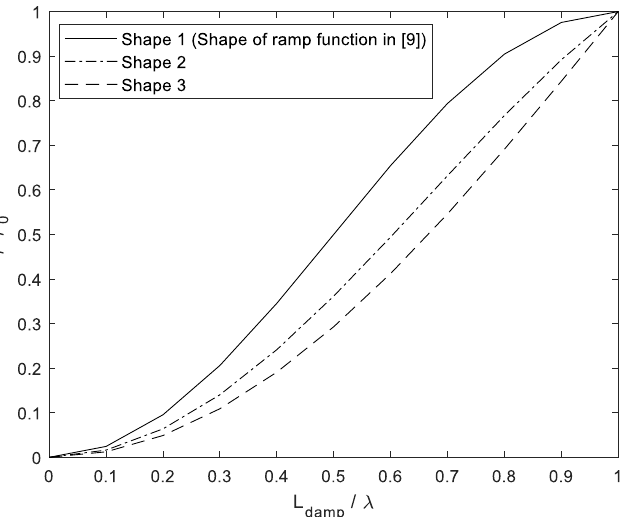
Figure 7. Various shapes of the ramp function for the damping coefficients: shape 1 ( 𝜃 = 𝜋 ), shape 2 ( 𝜃 = 3𝜋/4 ), shape 3 ( 𝜃 = 𝜋/2 ).